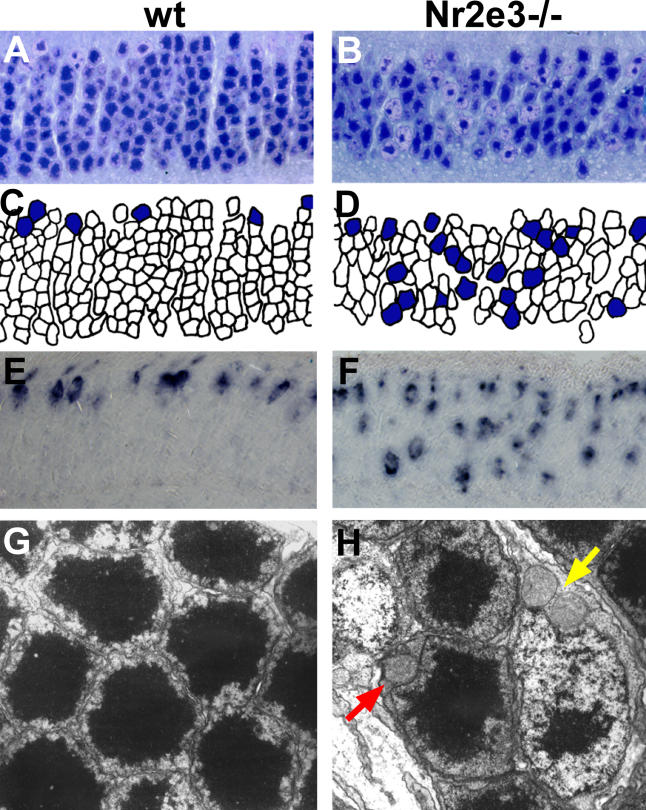
The rd7 Mutant Retina Contains a Morphologically Hybrid Photoreceptor Cell Type in Addition to Supernumerary S-Opsin–Positive Cones(A and B) Toluidine blue-stained semi-thin sections of the outer nuclear layer (scleral edge oriented up).(C and D) Hand-drawn diagrams of the cells in (A) and (B), respectively. Cells with the nuclear features of cones are highlighted in blue. Note that the number of such cells is greater in the mutant, and their cell bodies are scattered throughout the outer nuclear layer. In addition, the overall columnar architecture of the outer nuclear layer seen in the wild type is disrupted in this portion of the mutant retina. Other portions of the mutant retina with fewer supernumerary cone cells, however, retain the normal columnar appearance (unpublished data).(E and F) Images of the outer nuclear layer (scleral edge up) stained by in situ hybridization for S-opsin. Note the typical pattern of staining at the scleral edge of the outer nuclear layer in the wild type. The rd7 mutant retina shows supernumerary S-opsin–positive cells scattered throughout the outer nuclear layer in a distribution very similar to the supernumerary cone cells seen in (B). Since images (E) and (F) derive from different retinas than those depicted in (A) and (B), the location of the individual cells do not correspond.(G and H) Electron micrographs of the outer nuclear layer (10,000× magnification). Note the uniform distribution of rod cell bodies in the wild type (G). The cell bodies are nearly round and consist almost exclusively of a nucleus with a single, dense mass of heterochromatin. In the rd7 mutant (H), two types of cell are shown. The ovoid one with a lesser quantity of heterochromatin, paler euchromatin, and two juxtanuclear mitochondria (yellow arrow) represents a typical cone cell body. The adjacent cell with a more “rod-like” mass of heterochromatin and a single juxtanuclear mitochondrion (red arrow) represents one of the hybrid photoreceptors discussed more fully in the main text.